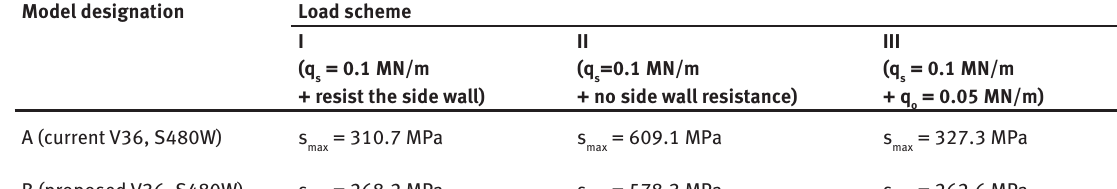
Table 5: Maximum stress values in the analysed arch supports Model designation